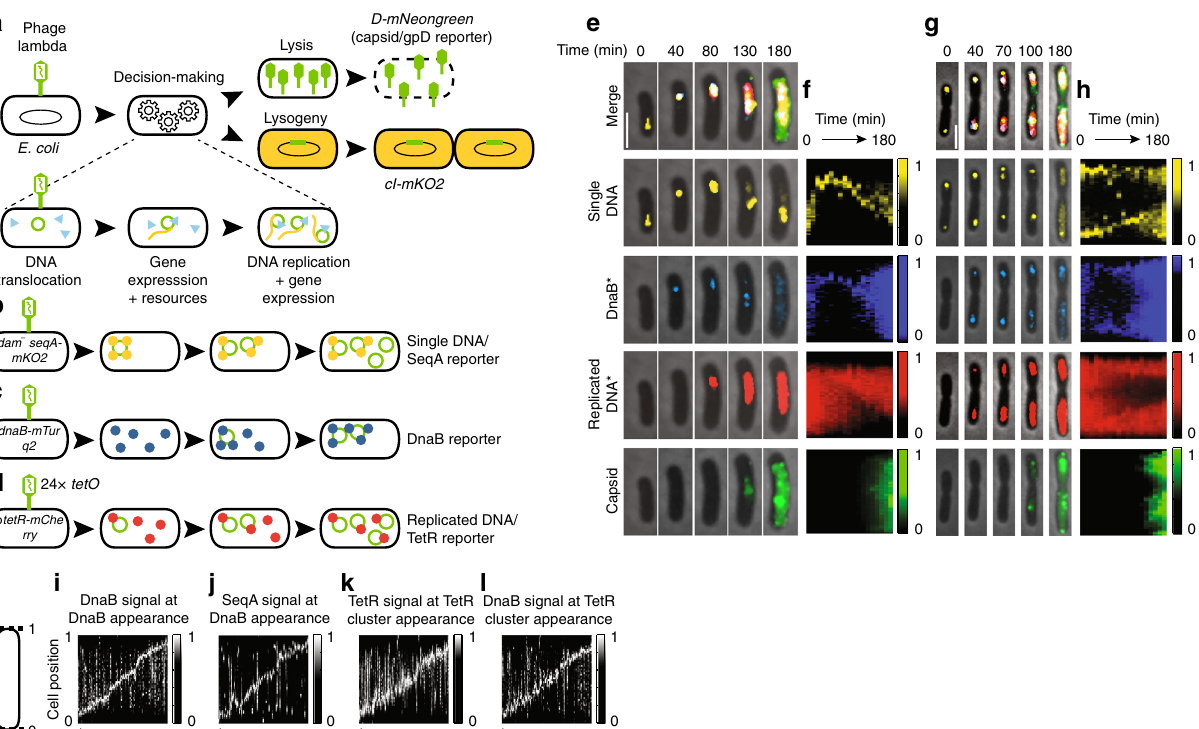
Fig. 1 Phage DNAs organize developmental processes into subcellular locations during infection. a Combination of phage processes results in decision- making. Lytic decisions reported by a D-mNeongreen translational fusion and lysogenic decisions reported by a cI-mKO2 transcriptional fusion. b SeqA system detects single molecules of phage DNA. Methylated phages infect dam − cells. Phage DNA is bound by SeqA-mKO2 proteins. Only phage DNA retaining methylation is labeled. c DnaB is an essential DNA replication resource. DnaB-mTurquoise2 fusion protein reports localization of DnaB. d Tet system detects replicated phage DNAs. Phage DNA bearing tetO arrays is labeled by TetR-mCherry binding. e Representative infected cell with reporters described in a – d undergoes lytic development. Representative cells in e and g chosen from three independent infection experiments. * indicates contrast is adjusted for each time point for clarity. DnaB and replicated DNA fi xed contrast images are shown in Supplementary Fig. 2b – e. All scale bars in this fi gure are 2 μ m. f Kymograph of the cell in e . Explanations for data analysis in Supplementary Fig. 1 and Supplementary Discussion. Fluorescence is normalized to the population maximum. g Representative infected, lytic cell with two subcellular areas of development. h Kymograph of the cell in g . Fluorescence is normalized to the population maximum. i DnaB heat maps for lytic cells at their DnaB appearance time point are arranged by the position of DnaB. Cell to the left of i describes how location is represented for i – l . Fluorescence of each cell is normalized to its own peak brightness for i – l . n = 91 cells for i – l . j SeqA heat maps for lytic cells are arranged in the same order and time points as in i to compare SeqA and DnaB. k TetR heat maps for lytic cells at their TetR cluster appearance time point are arranged by the position of TetR. l DnaB heat maps for lytic cells are arranged in the same order and time points as in k to compare DnaB and TetR. Source data are provided as a Source Data fi